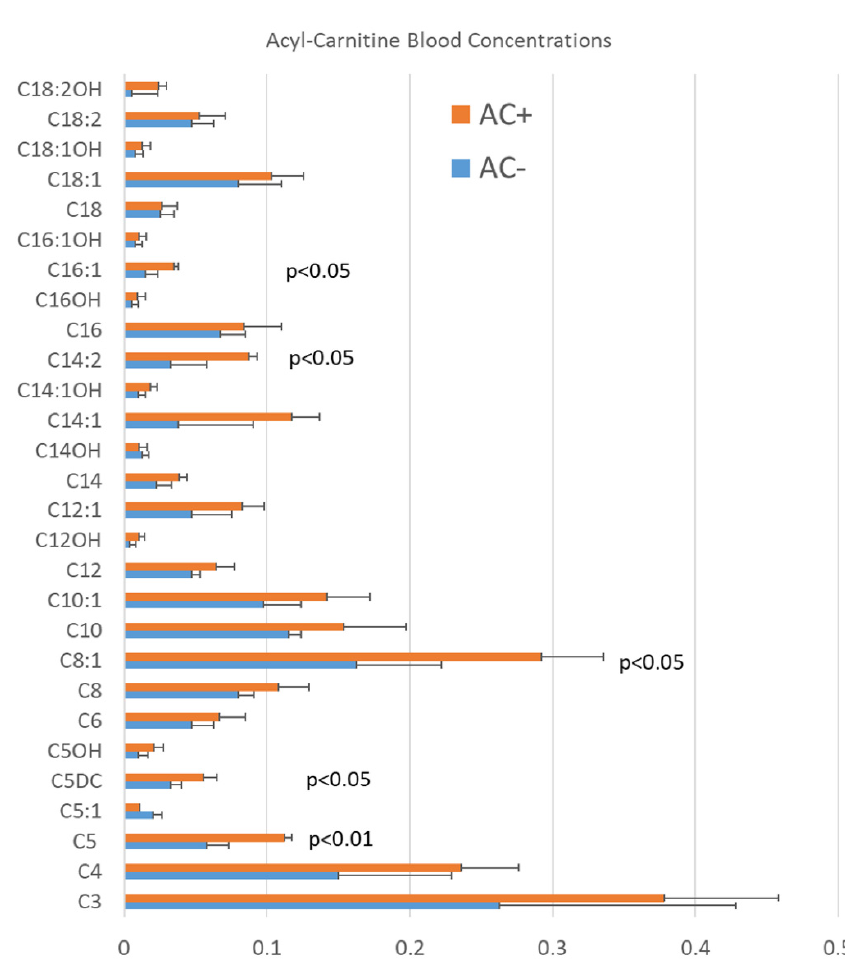
Figure 1. Average blood acyl-carnitine (AC) levels in studied patients with autism spectrum disorder (ASD) with (AC+, orange bars) and without (AC − , blue bars) elevations in acyl-carnitines. Short-chain (C5, C5DC), medium-chain (C8:1), and long-chain (C14:2, C16:1) acyl-carnitines (AC) were significantly elevated in a subset of studied patients with ASD. Patients with high plasma AC levels had consistent AC elevation defined as at least three AC clinically significantly elevated (outside the normal reference range) in repeated analyses.